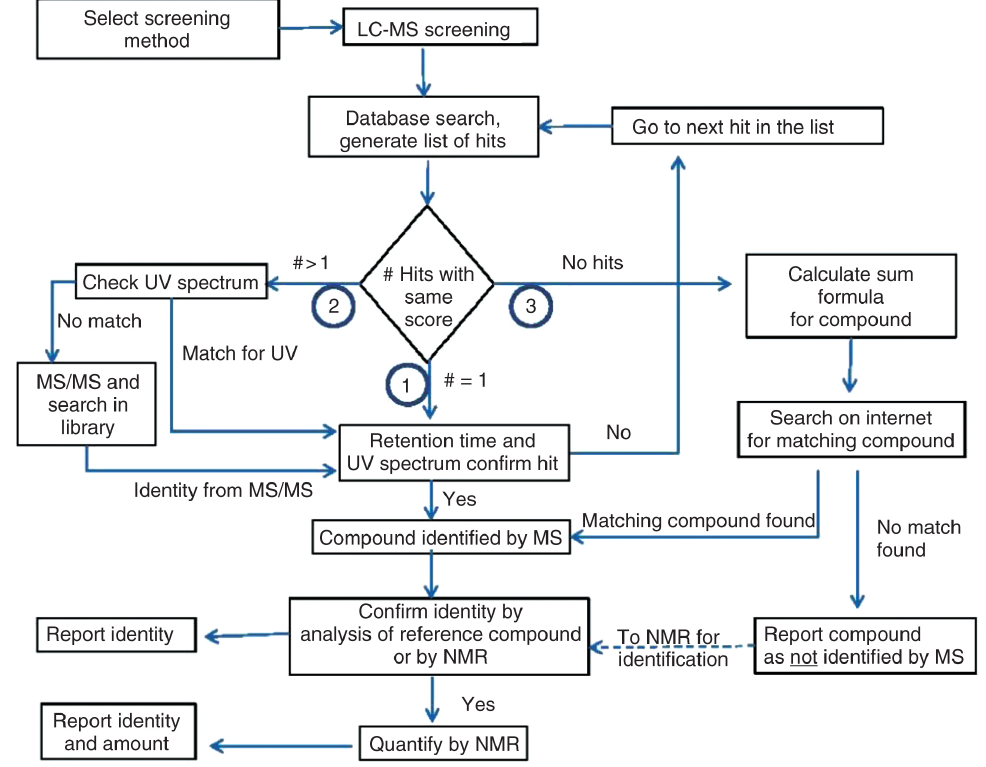
Figure 2: Screening procedure for counterfeit/illegal medicines using LC-QTOF-MS and NMR for identification and quantification. Reprinted from Johansson et al. (2014) with permission from